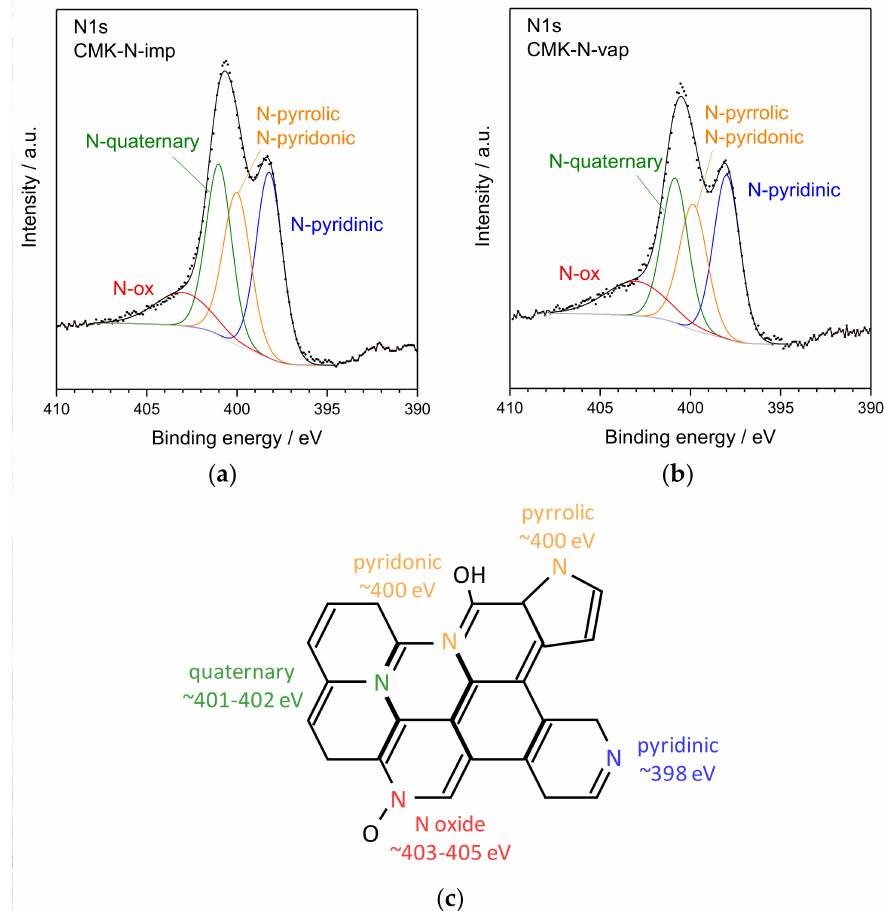
Figure 1. XPS high-resolution N1s spectra of: ( a ) CMK-N-imp; ( b ) CMK-N-vap; ( c ) Illustration of nitrogen groups in carbon and their associated binding energy